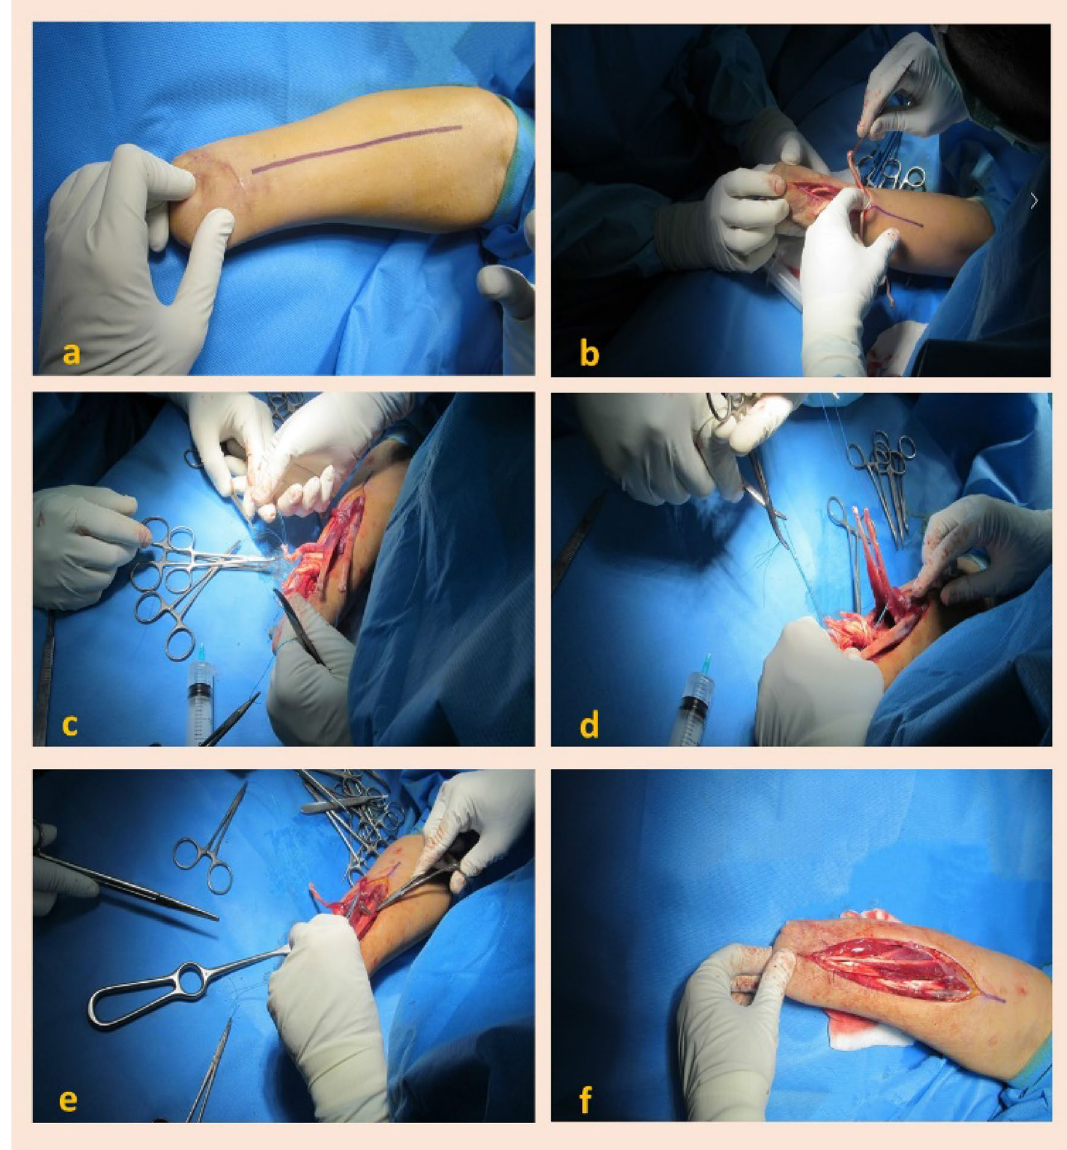
Figure 2. Tendon transfer operation technique. The skin and subcutaneous tissue are exposed ( a ). The viability and function of each pair of muscles are assessed with the cautery electric stimulation ( b ). Corresponding to each target muscle in the volar, the dorsal muscles are selected ( c ). Then, along with the distal third of the forearm, volar and dorsal aspects are exposed to reach the interosseous membrane, after which the flexor tendons are transferred to the corresponding extensor tendons under moderate tension ( d ). Magnetic tags are placed in the most superficial flexor level inside the musculotendinous junction ( e ). Skin and subcutaneous tissue repair ( f